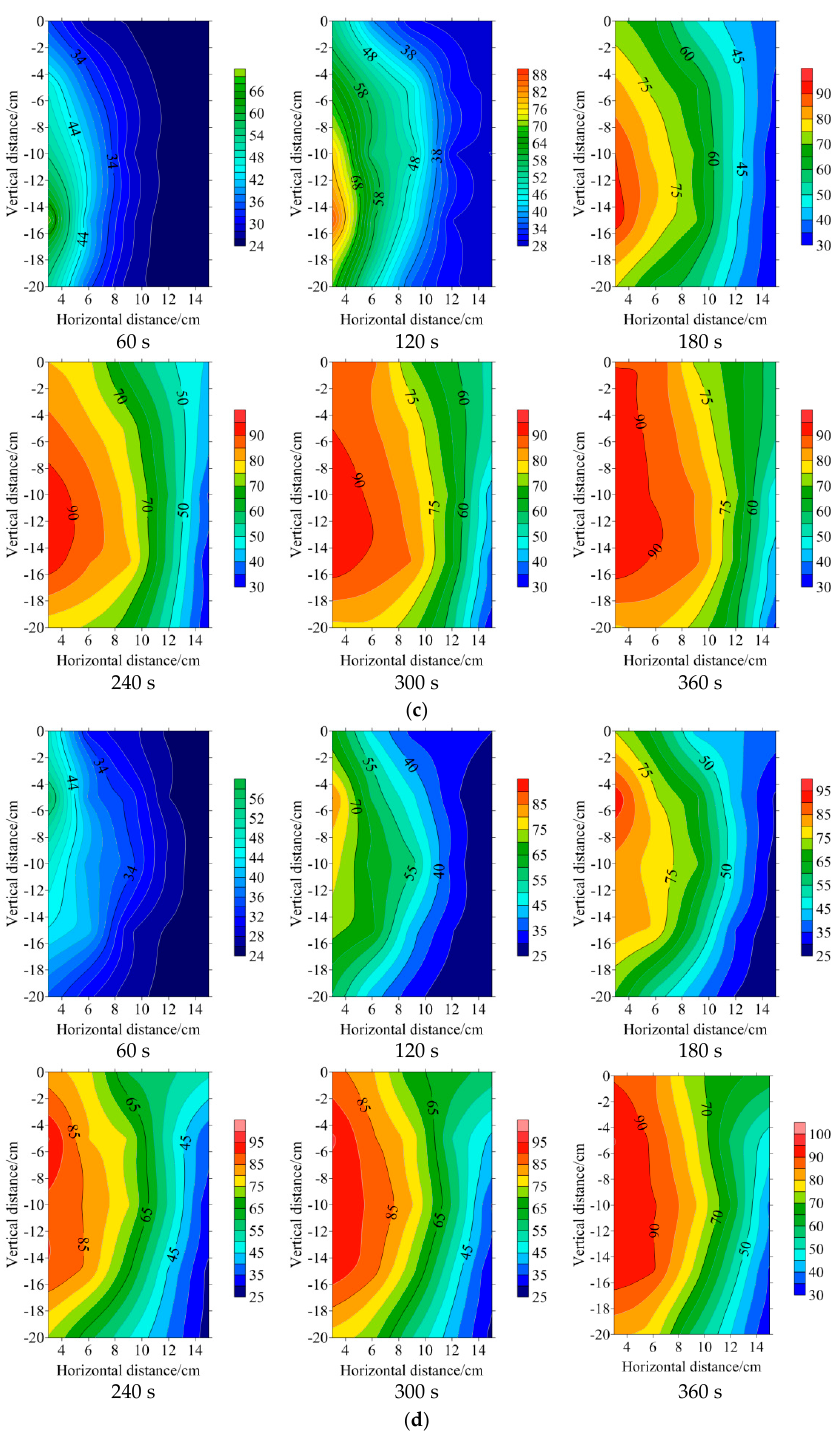
Figure 13. ST distribution: ( a ) <2 mm; ( b ) 7–17 mm; ( c ) 17–27 mm; ( d ) >27 mm. Note: The legend indicates the ST/°C and 60 s means that the disinfection time ( t ) is 60 s, 360 s means the disinfection time is 360 s, etc. The same conditions apply in the following section.